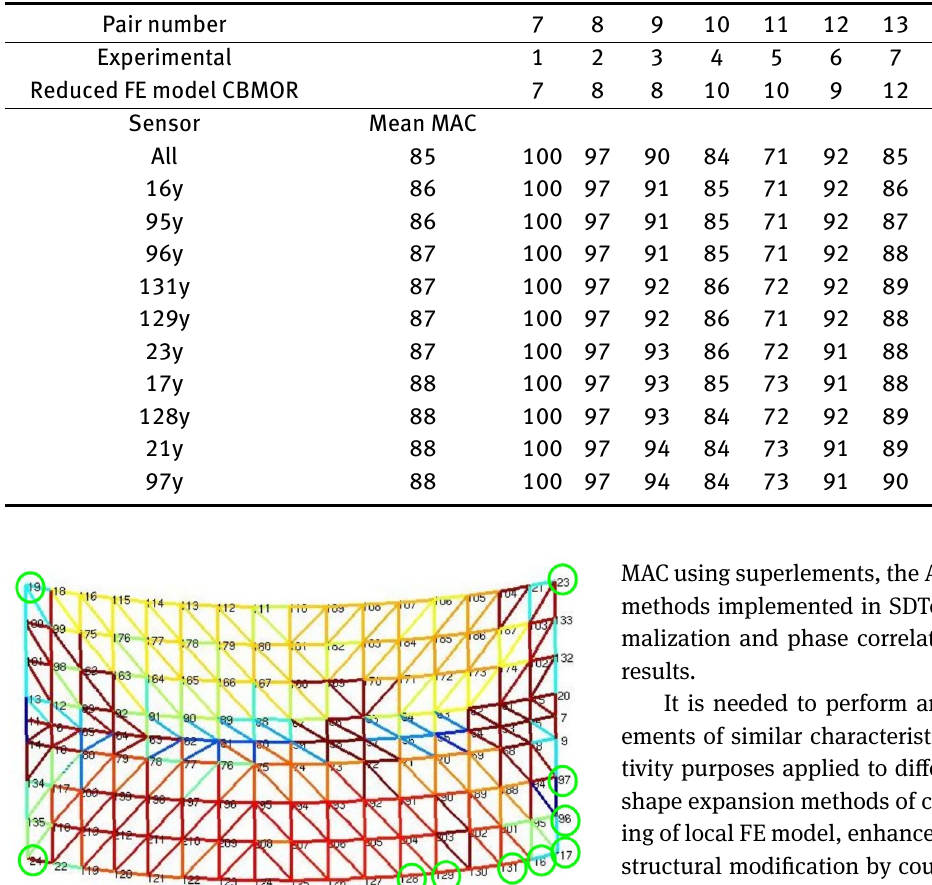
Table 3: MACco results - Reduced model versus experimental results.